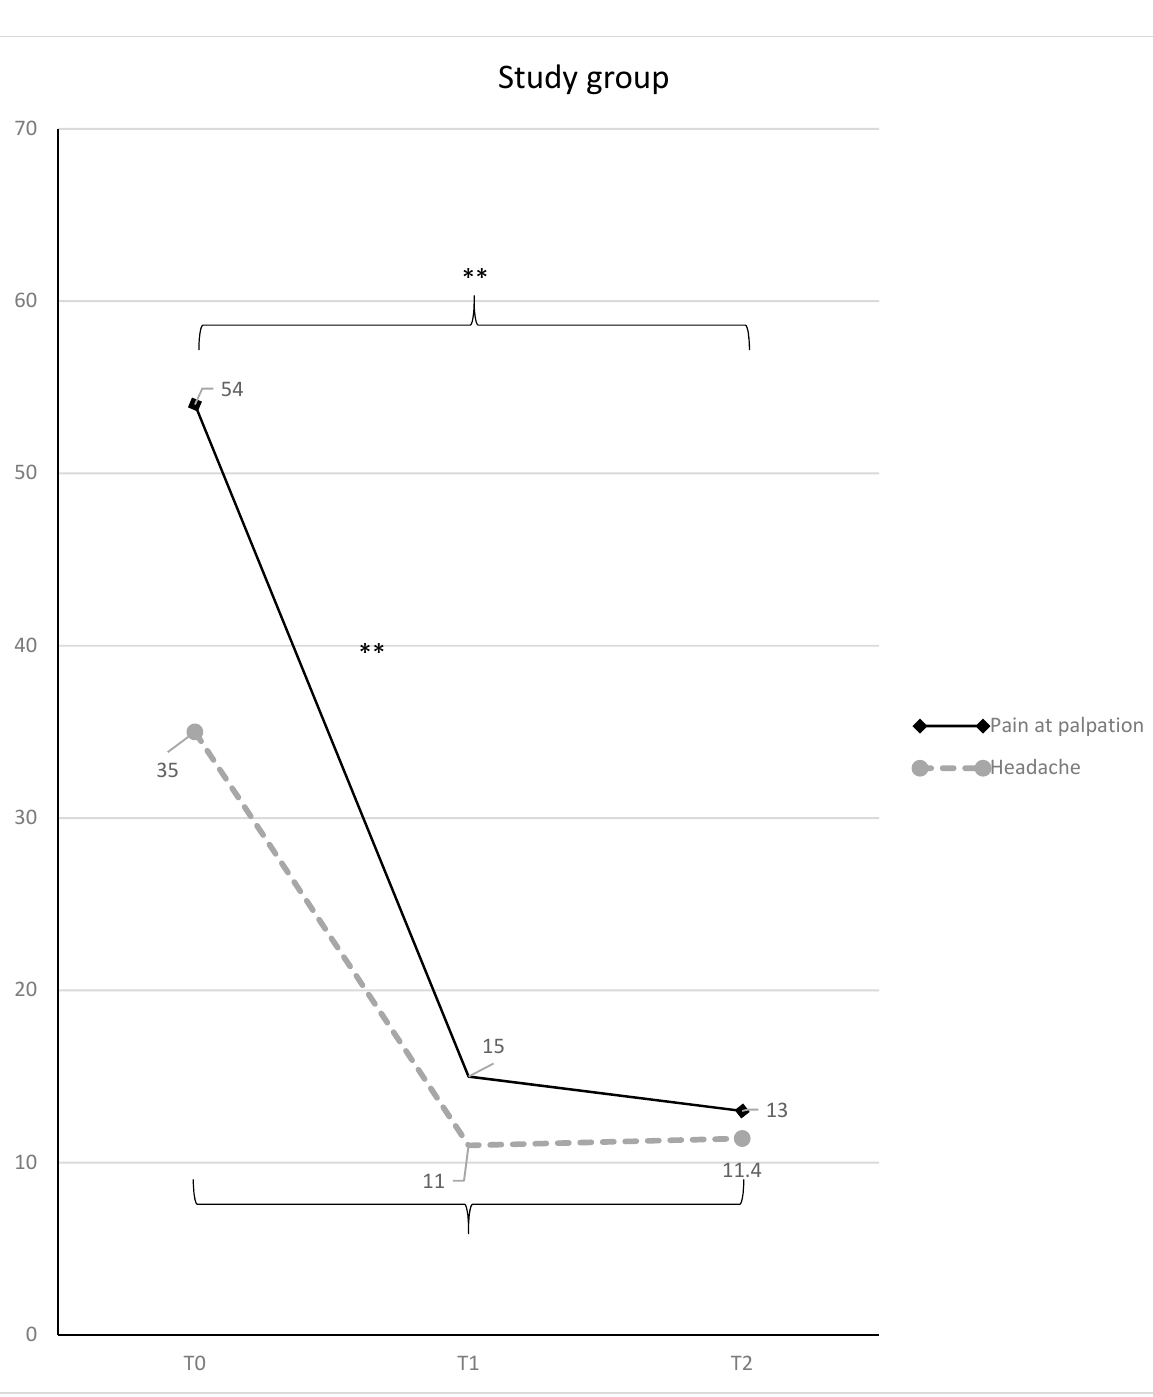
Figure 3. Muscle pain at palpation and headache (mean VAS scores and SD) in the study group, with statistically significant differences overtime (* = p < 0.05; ** = p < 0.01).